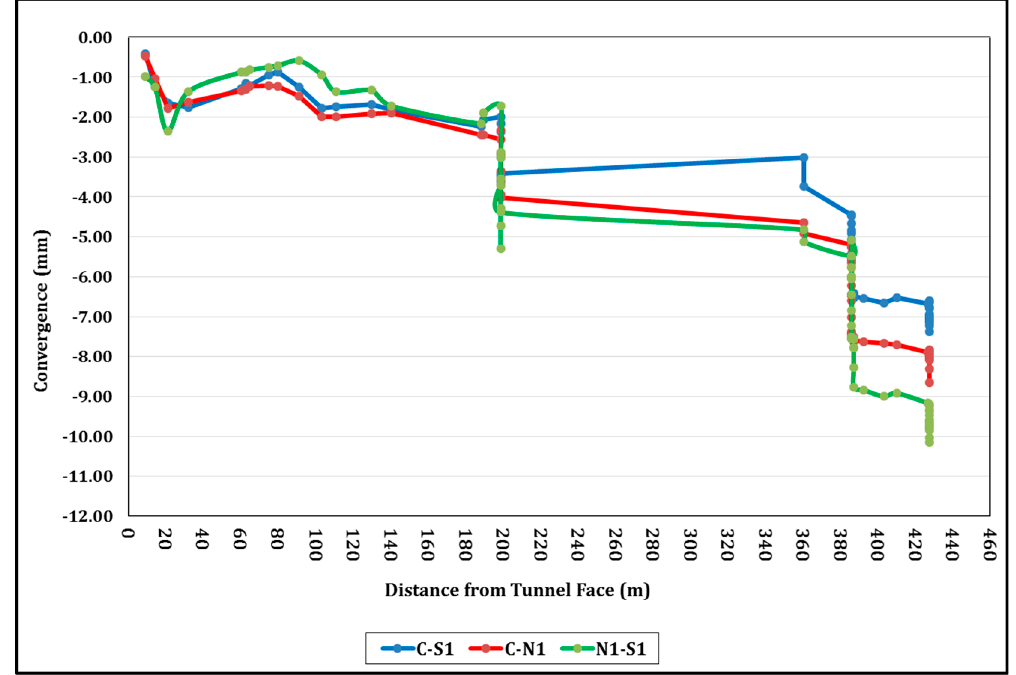
Figure 9. Convergence changes at the chainage 1 + 787 as the measurement point distance to the tunnel face increases.